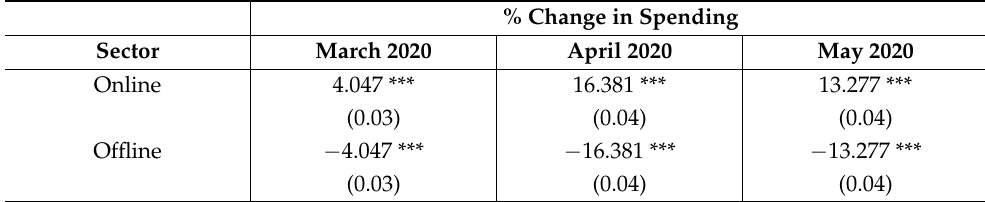
Table 4. Estimated Changes in Expenditure Shares across Shopping